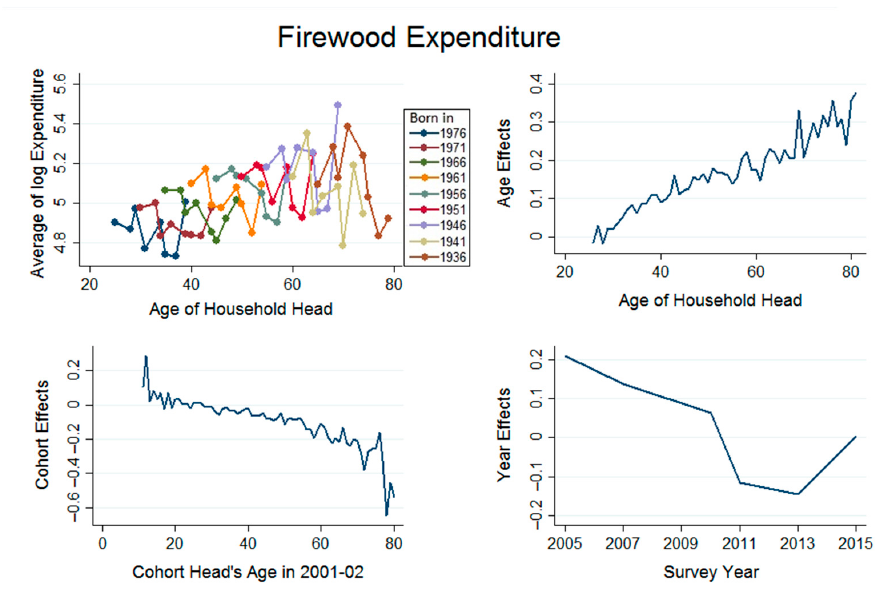
Figure 9. Firewood Figure 9. Firewood Expenditure.